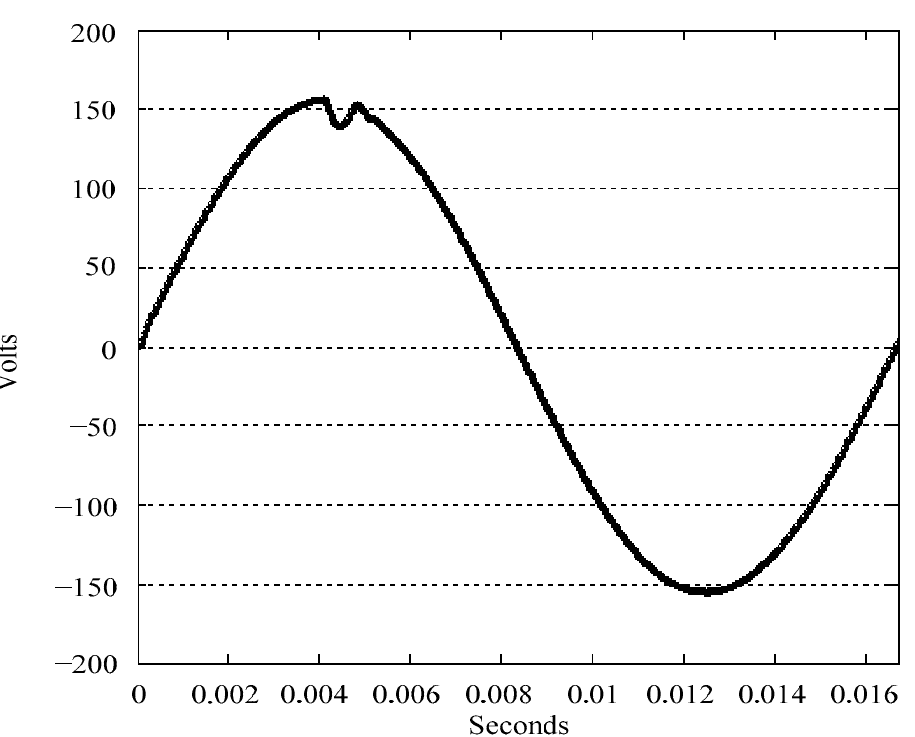
Figure 4. Simulated output voltage with the conventional SMC under stepped load.